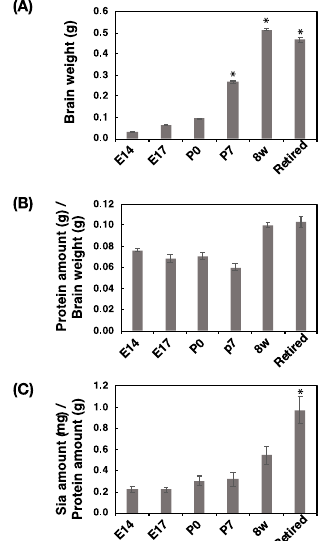
Figure 1. Comparison of brain weight, protein concentration, and Sia concentration at different developmental stages. Brains from six different developmental stages (E14, E17, P0, P7, 8 w, and retired (older than six months) ( n = 3)) were used. ( A ) Comparison of brain weights of six different developmental stages. ( B ) Protein amount (g) per brain weight (g). Brains were homogenized using lysis buffer and a bicinchoninic acid (BCA) assay was performed to determine the protein concentration. ( C ) Sia amount (mg) per protein amount (g). Brain homogenate was treated with strong acid for hydrolysis of sialylglycoconjugates. All Sia was completely released and labelled with 1,2-dimethylenedioxybenzen (DMB). Sia–DMB were separated by a Wako Handy octadecylsilyl (ODS) column (250 × 4.6 mm, Wako). The absolute amount of Sia was calculated based on the authentic Neu5Ac. * p < 0.05.